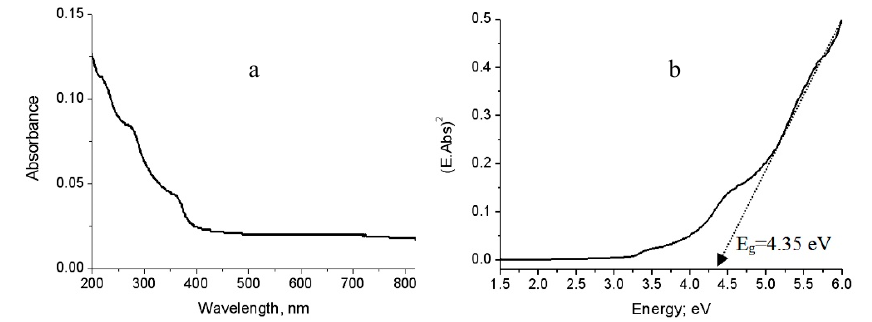
Figure 8. The prepared alumina nanoparticles: ( a ) Absorbance spectrum and ( b ) Band gap energy.